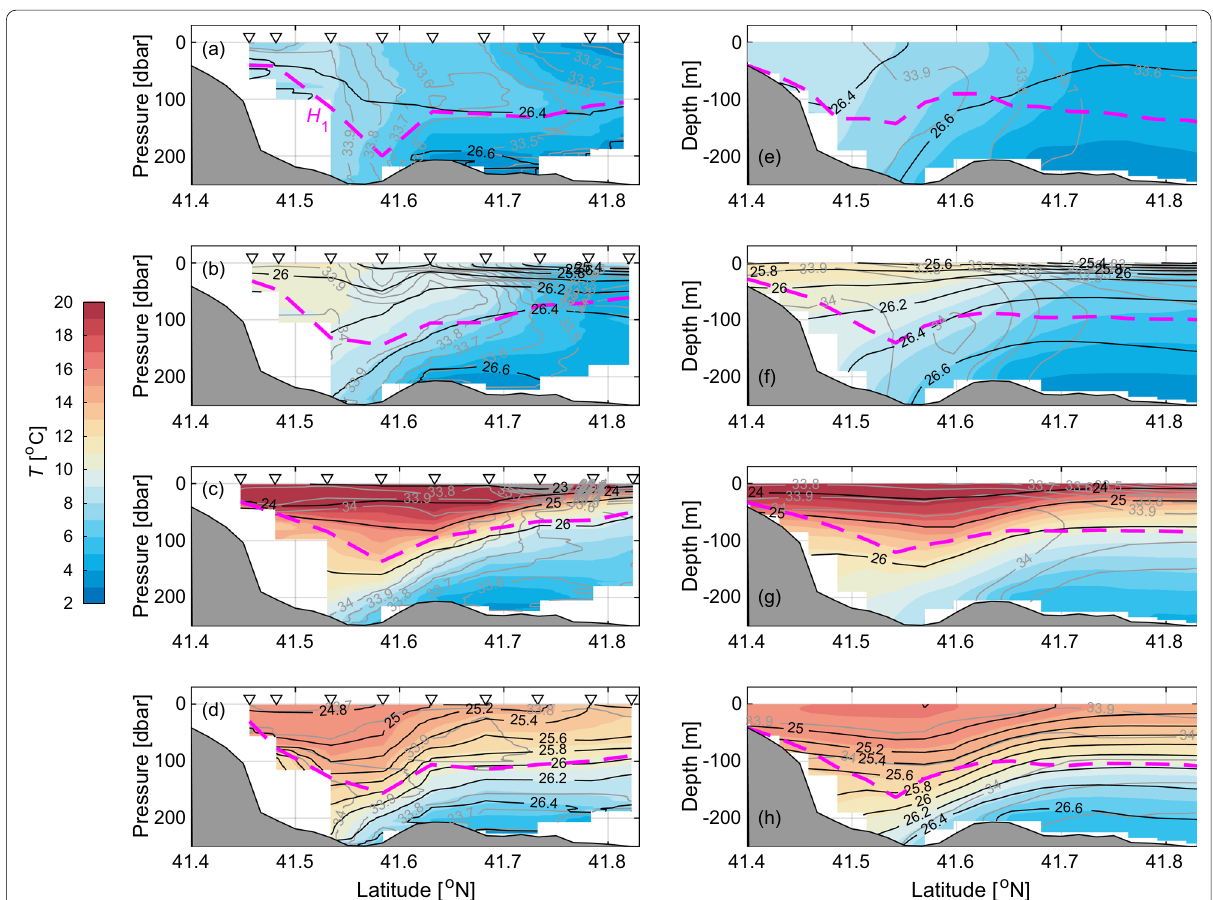
Fig. 2 Vertical transect of seasonal means of temperature (color), salinity (gray contours), and potential density anomaly, σ θ (black contours), obtained from the shipboard observations along the Shiriya–Esan line (estimated from the JCOPE-T DA data) in a ( e ) winter, b ( f ) spring, c ( g ) summer, and d ( h ) autumn, shown in the left (right) column. Triangles shown in the left column are the latitude of each station. The dashed magenta line is the depth of the upper layer, H